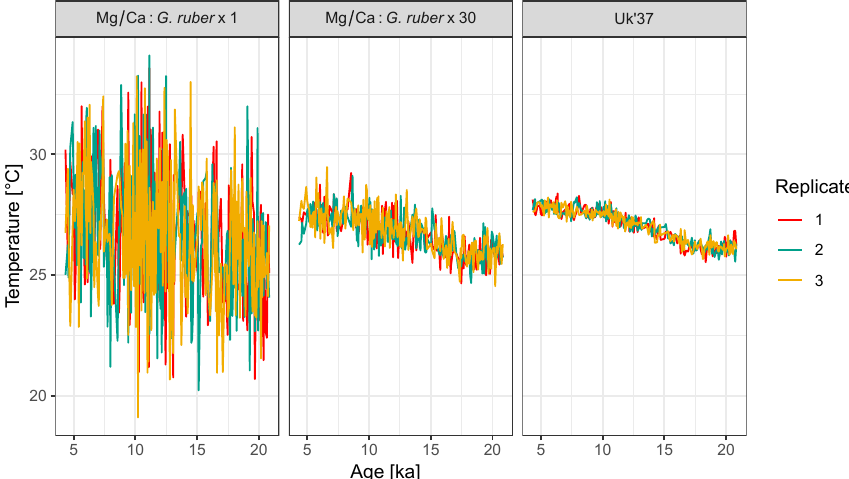
Mg Ca: G. ruber x 1 Mg Ca: G. ruber x 30